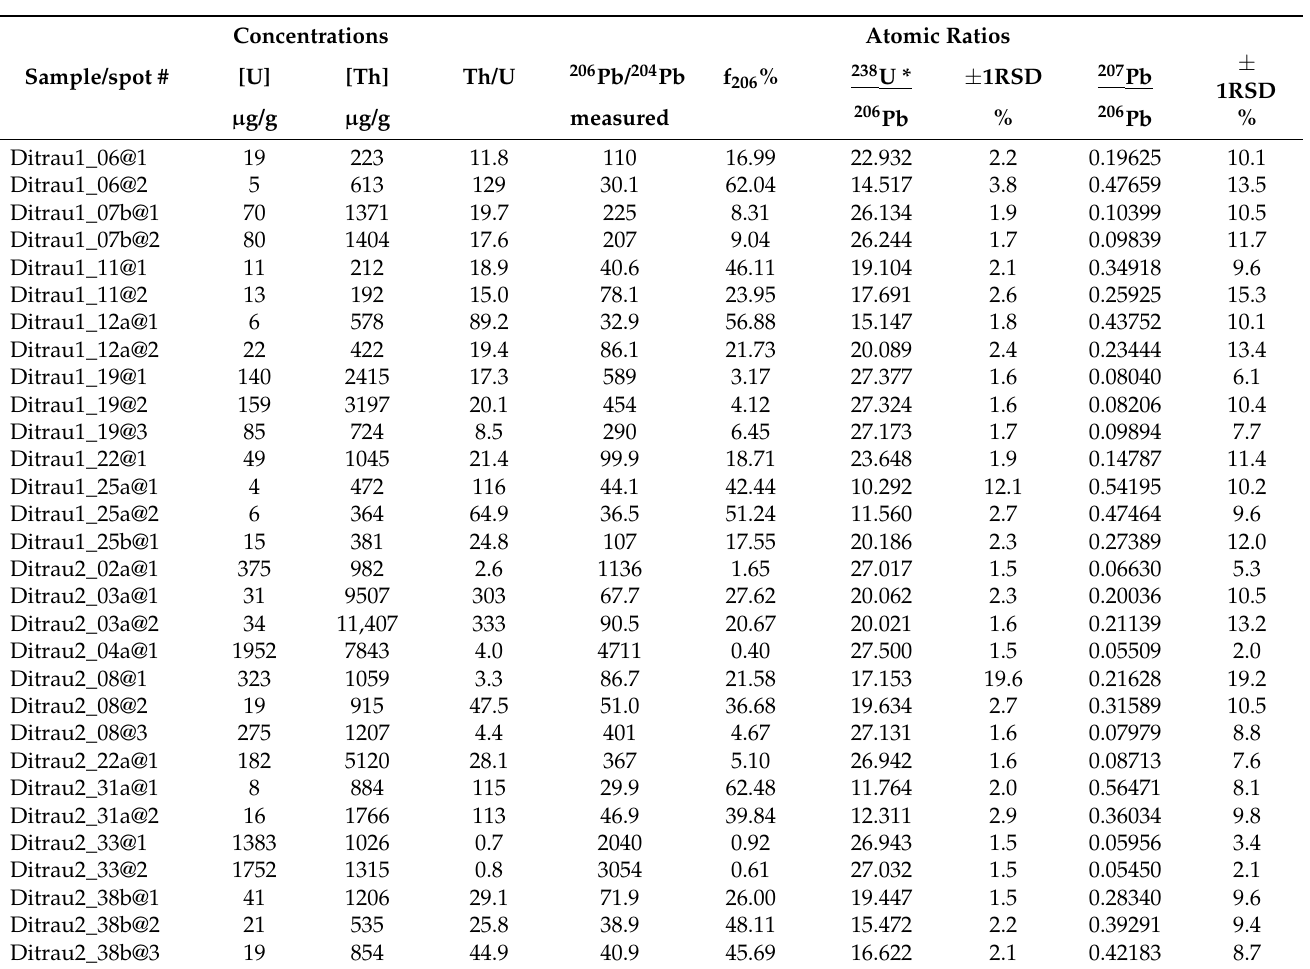
Table 2. Zircon U-Th-Pb SIMS